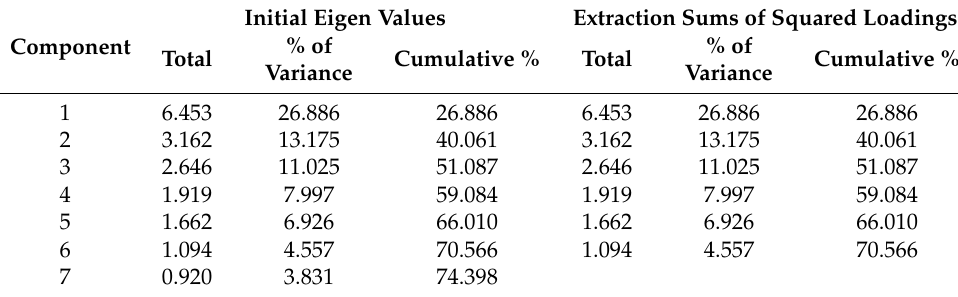
Table 6. Total variance explained.